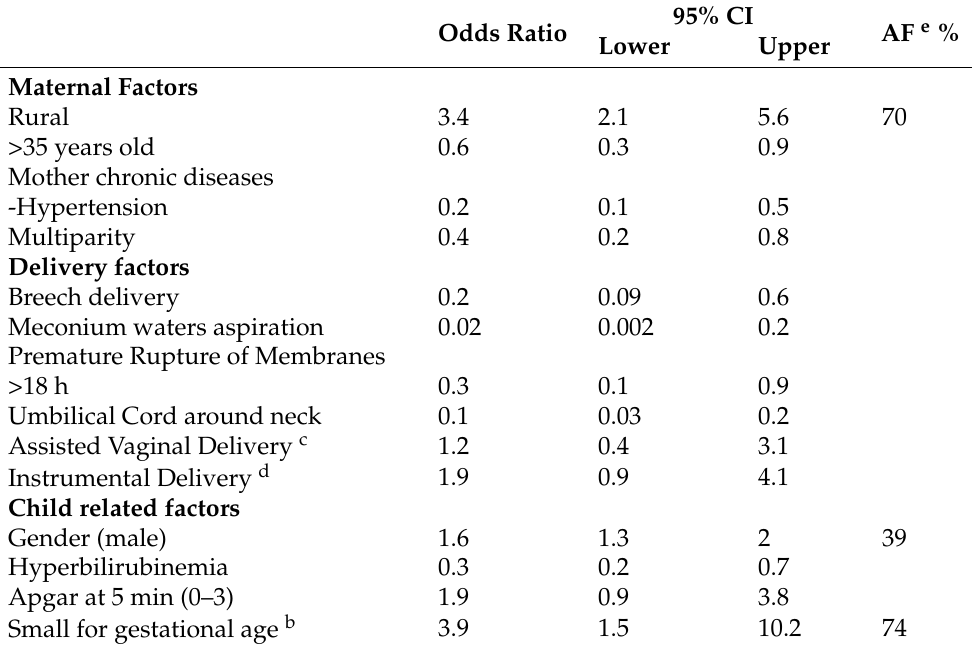
Table 6. Multivariable analyses a of risk factors for cerebral palsy (CP) in singletons born at term.